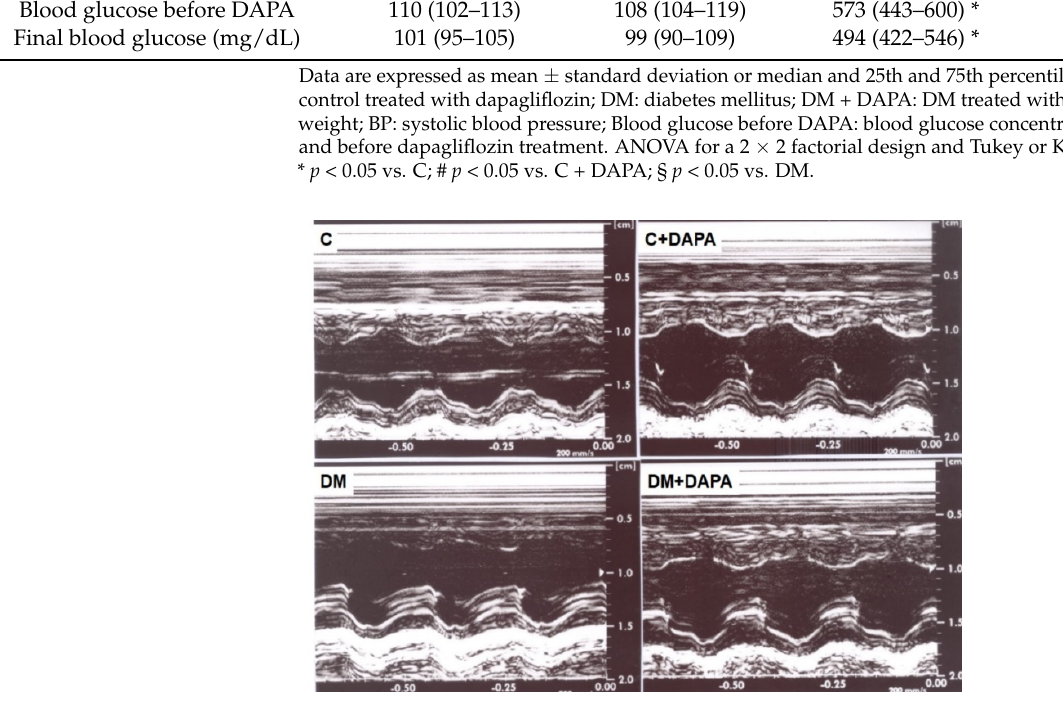
5 of 15 Table 1. Body weight, systolic blood pressure, and blood glucose. C ( n = 14)